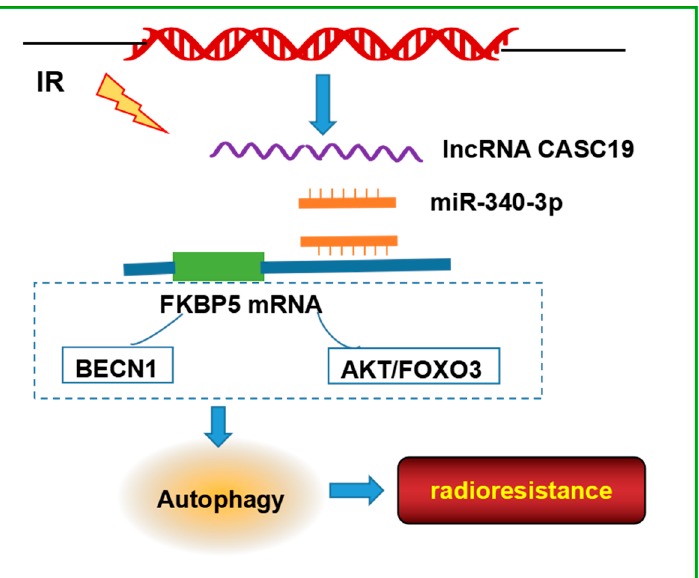
Figure 7. Schematic model of the pathways regulated the radioresistance of NPC cells. CASC19, as a competing endogenous RNA, bound to miR-340-3p via the lncRNA sponging mechanism and abolished the suppression of FKBP5 expression caused by miR-340-3p. FKBP5 may bind with BECN1 or regulate AKT/FOXO3 pathway, resulting in an increase in autophagy, thereby enhancing the radioresistance of NPC. The signaling pathways in the dashed box are derived from studies in the literature.